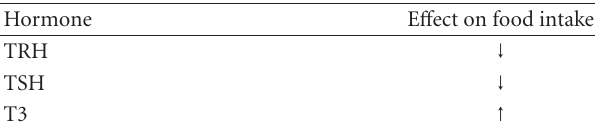
Table 1: E ff ect of TRH, TSH, and T3 on food intake. Central administration of TRH and TSH in rodents causes a reduction in food intake [8, 12, 13]; similar e ff ects on food intake are seen following peripheral administration of TRH [14]. Central and peripheral administration of T3 increases food intake